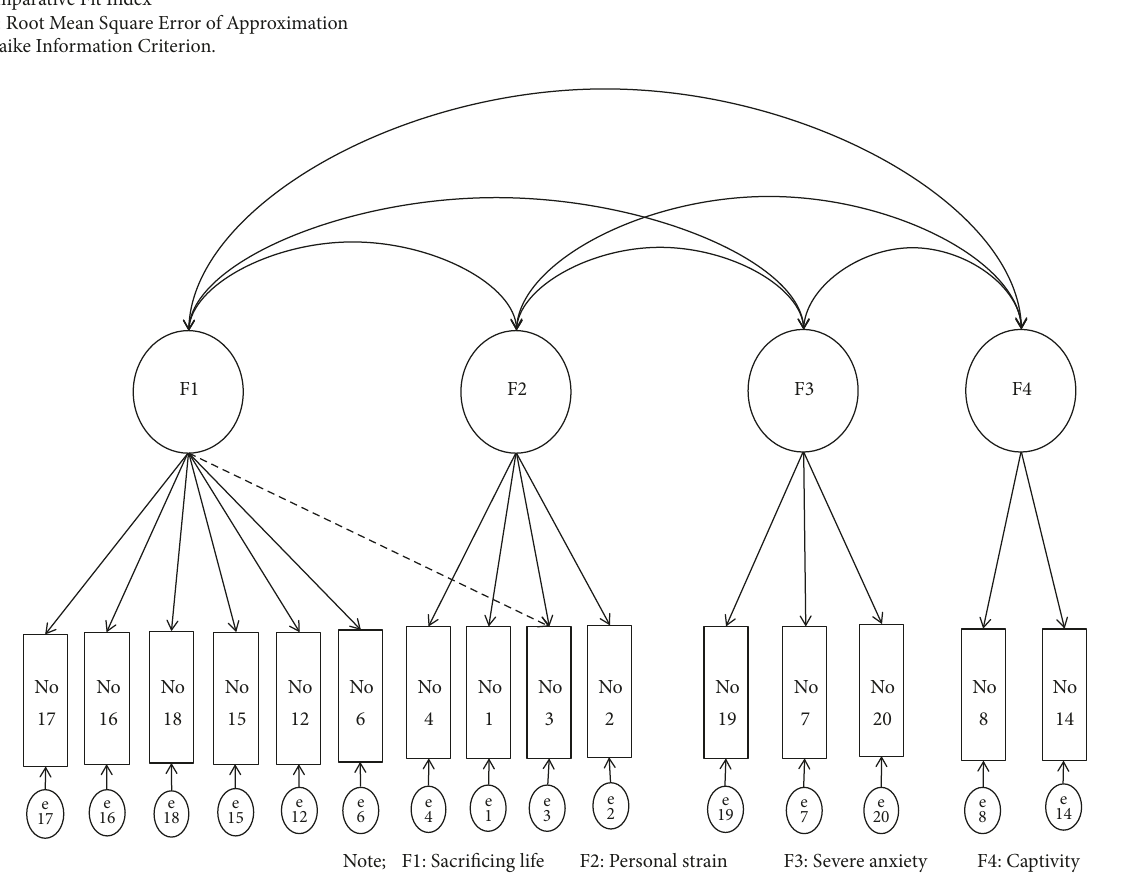
Figure 1: Four-factor structure: 𝜒 2 /df ratio = 2.678 (222.307/8 3 ∗ ), CFI = 0.908, RMSEA = 0.083, AIC =